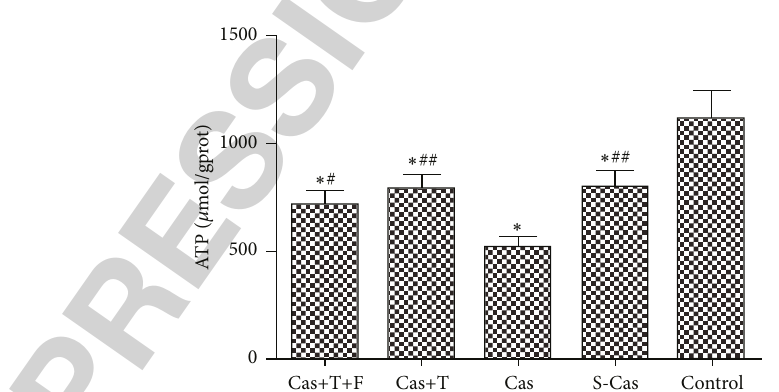
Figure 5: Effects of castration and testosterone on the protein expression of GLUT-4. (a) Western blotting result for GLUT-4 protein level. (b) Quantitation of GLUT-4 protein level. Values are means ± SD; 𝑛 = 3 . S-Cas: sham-castration; Cas: castration; T: testosterone; F: flutamide. ∗ 𝑃 < 0.001 versus control group; # 𝑃 < 0.001 versus Cas.